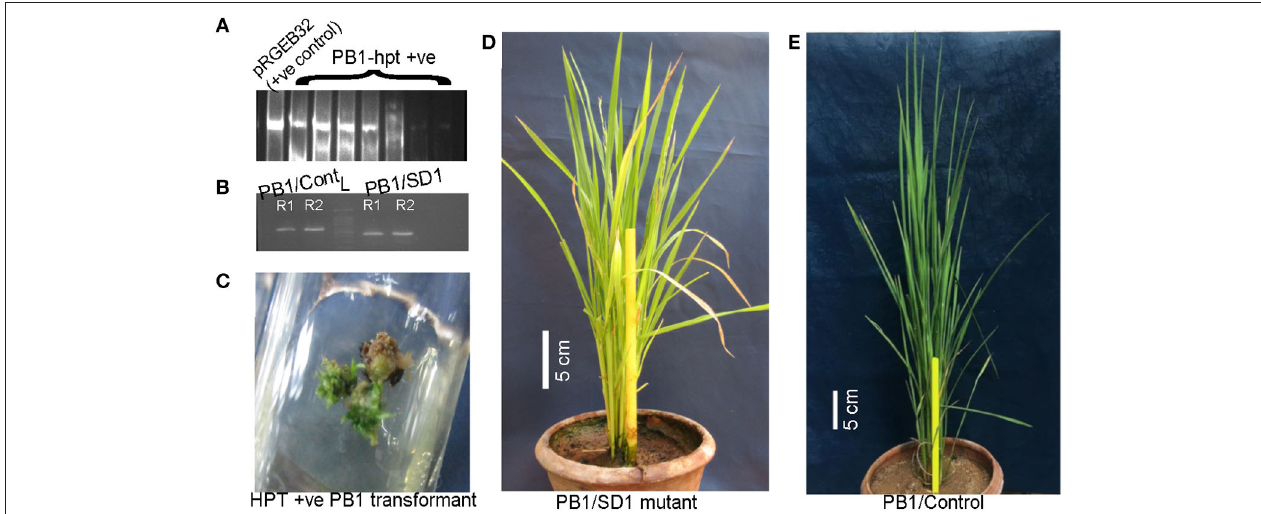
FIGURE 7 | Sd1 mutants of cultivar Pusa Basmati-1 (PB-1) were developed using CRISPR-Cas9. (A) HPTII screening of PB-1/SD1 transformants (lane 1—pRGEB32 plasmid as positive control, other lanes—PB-1/hpt positive transformants); (full-length gel presented in Supplementary Material 11 ); (B) A PB-1/SD1 mutant was observed with a small deletion in the exon 1 of the OsGA20ox2 gene; lanes 1 and 2: biological duplicate of PB-1/Control and lanes 3 and 4: biological duplicate of PB-1/SD1 (cropped gel image; full-length gel is presented in Supplementary Material 12 ). (C) Shoot initiation from the hygromycin positive calli. (D,E) PB-1/SD1-mutant and PB-1-control respectively; scale bars: 5